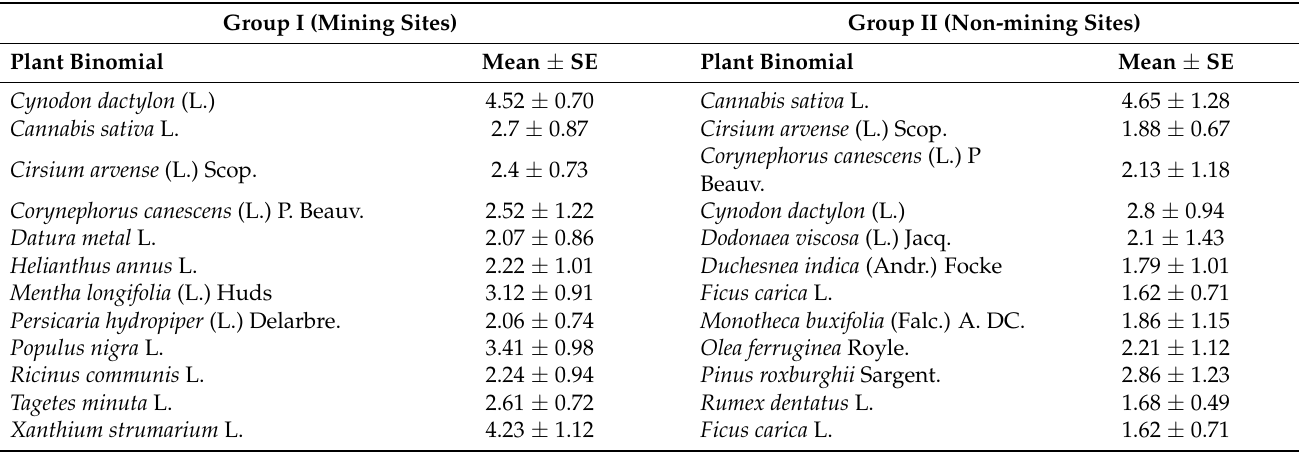
Table 1. Mean importance value index of dominant plant species in Group I (mining sites) and (Group II) non-mining